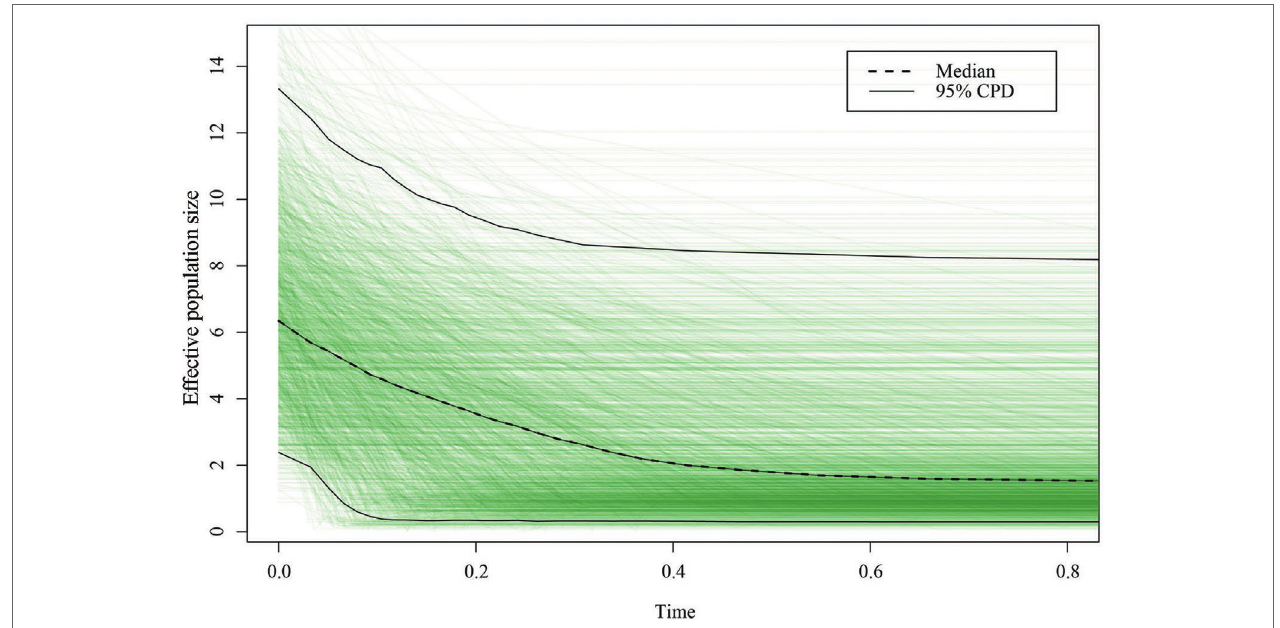
FIGURe 6 | Extended Bayesian skyline analysis based on chloroplast DNA (cpDNA) of Pterocarya stenoptera. The x-axis represents the time before present (Ma) and the y-axis represents the effective population size. The dashed and solid lines indicate the median and 95% highest posterior density intervals, respectively.